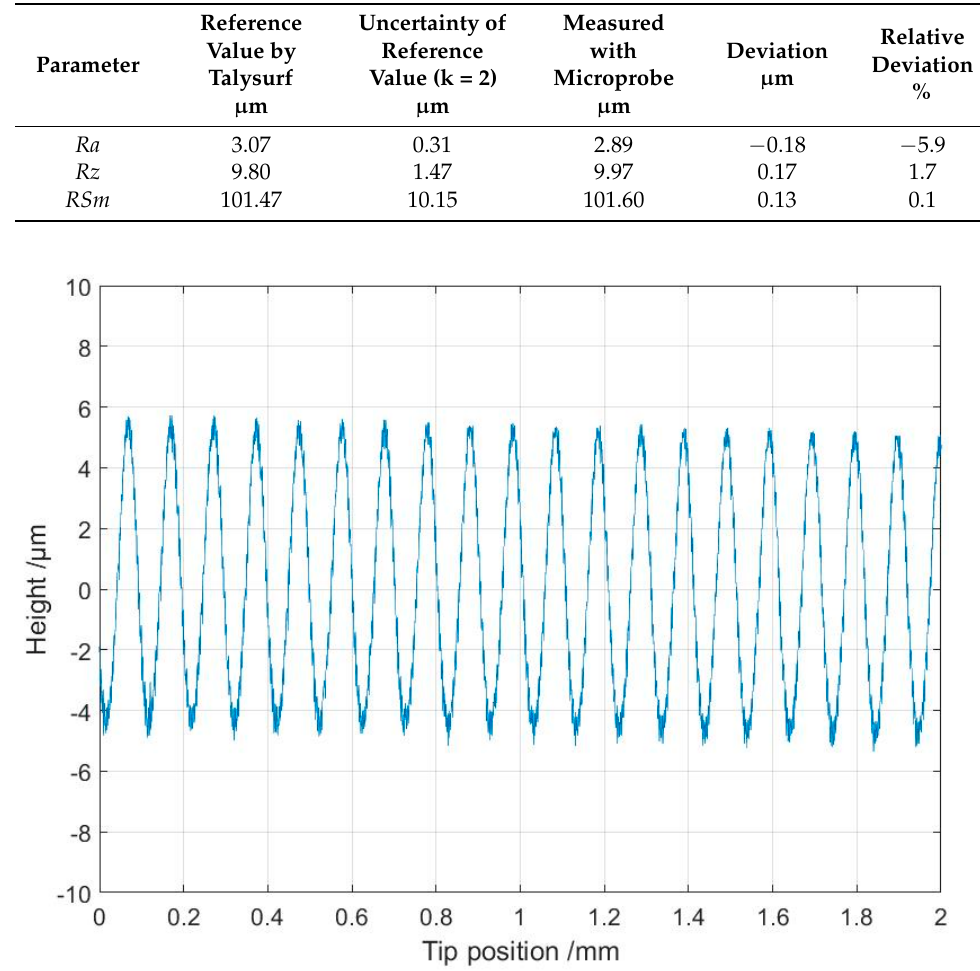
Figure 9. Partial section of the measurement of type 178-601 surface roughness standard using the microprobe setup. microprobe